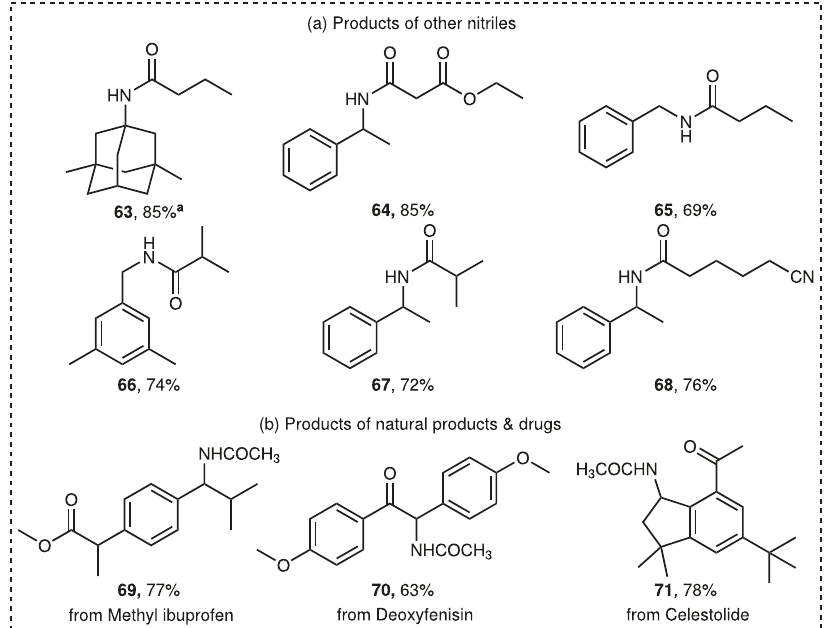
Fig. 4 Reaction scope other nitriles and the modi fi cation of natural products and drug molecules. a Products of other nitriles. b Products of natural products & drugs. Conditions: substrate (0.5 mmol), H 2 SO 4 (54 μ L, 1 mmol, 0.33 M), n Bu 4 NBF 4 (0.1 M), CH 3 CN (3 mL), 5 mA; a Conditions: substrate